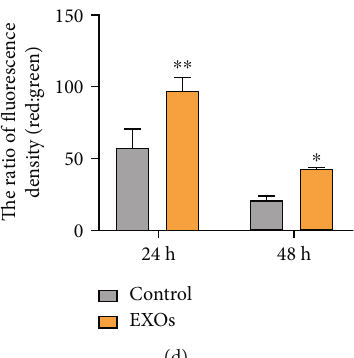
Figure 3: hBMSC-EXOs promote cell migration and mitochondrial function in chondrocytes. Rabbit primary chondrocytes were treated with hBMSC-EXOs at 1 : 0 × 10 9 /ml for 24h or 48 h. Cell migration and mitochondrial membrane potential were assayed. (a) hBMSC- EXOs stimulate cell migration. Wound healing assay was used to evaluate cell migration. Scale bar = 100 μ m . (b) Quantitative data for wound healing assay as shown in (a). (c) hBMSC-EXOs increase the mitochondrial membrane potential. Representative fl uorescence images for JC-1 staining were shown. Scale bar = 100 μ m . (d) Quantitative analysis for JC-1 staining as shown in (c). n = 3 . Values are presented as mean ± SEM . ∗ P < 0 : 05 , ∗∗ P < 0 : 01 , and ∗∗∗ P < 0 : 001 , versus the control group, one-way